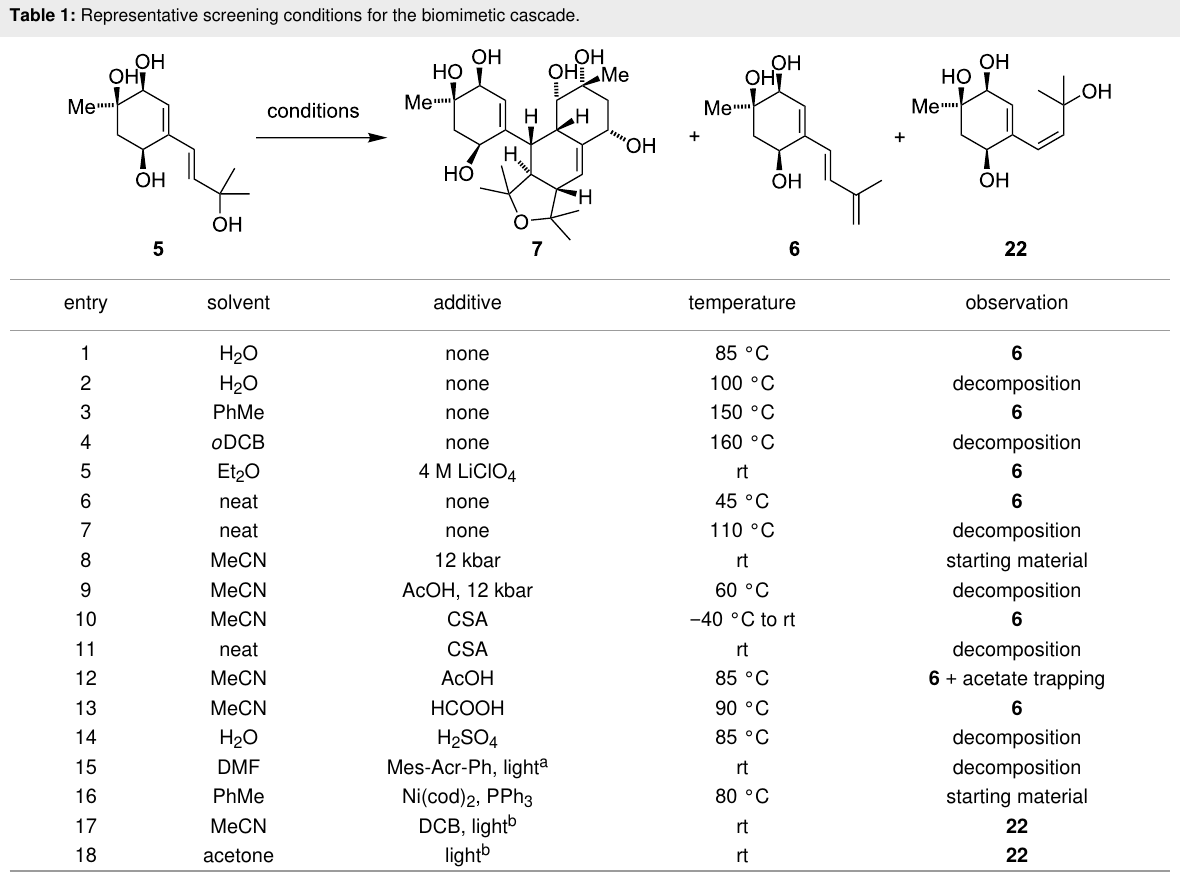
Table 1: Representative screening conditions for the biomimetic